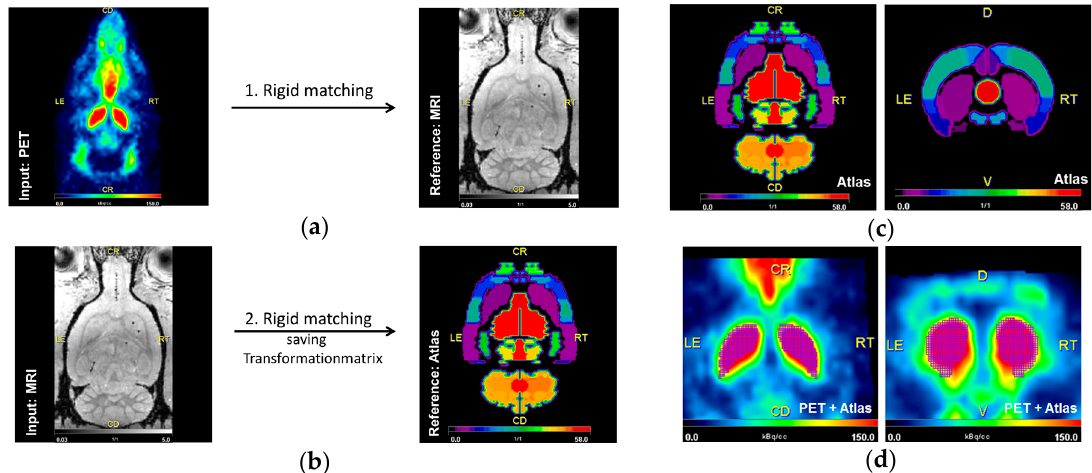
Figure 7. ( a , b ) Workflow of the transformation process using rigid matching. In a first step PET (input) was transformed to the matrix of the animal-specific MRI (reference) ( a ). Secondly, the animal-specific MRI (input) was transformed to the matrix of the Schiffer atlas and the transformation matrix was saved and finally applied to PET data ( b ). ( c , d ) Example of the delineation of the left and right striatum (purple grid) and the cerebellum (orange grid) in PET ( d ) with published Schiffer atlas ( c ) in a control animal (sham-6-OHDA + sham-BoNT-A).